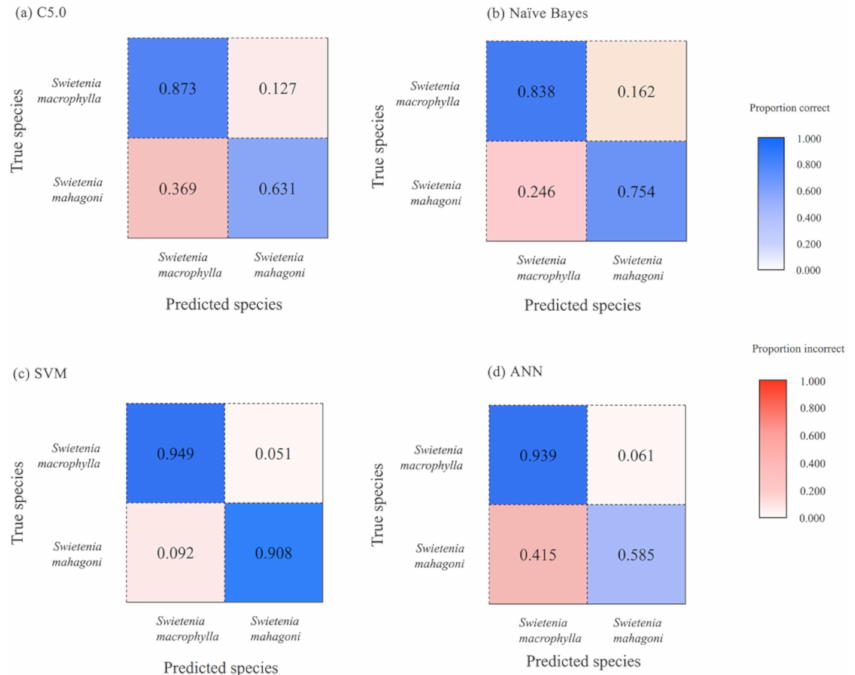
Figure 4. Confusion matrices for discriminating between Swietenia mahagoni and Swietenia macrophylla : ( a ) Decision Tree C5.0, ( b ) Naïve Bayes, ( c ) Support Vector Machine, ( d ) Artificial Neural